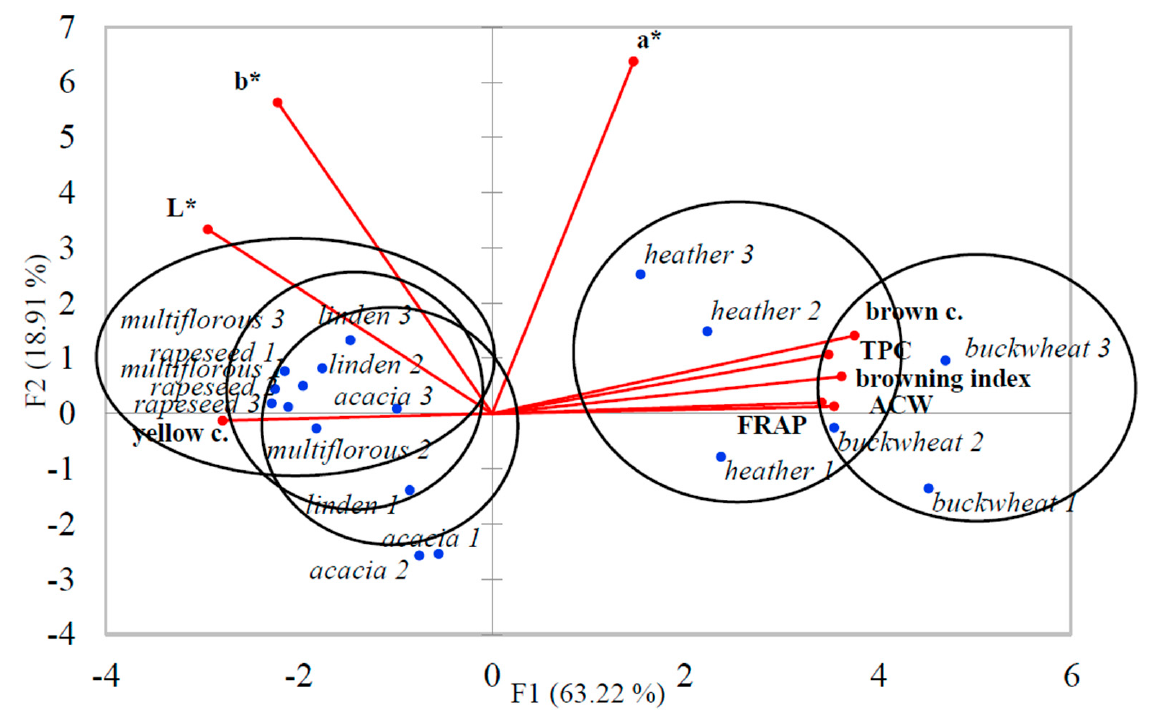
Figure 3. PCA biplot for honey samples from all producers (1–3) with nine variables (browning index, color parameters: L*, a*, b*, yellow and brown color, TPC, ACW, and FRAP).